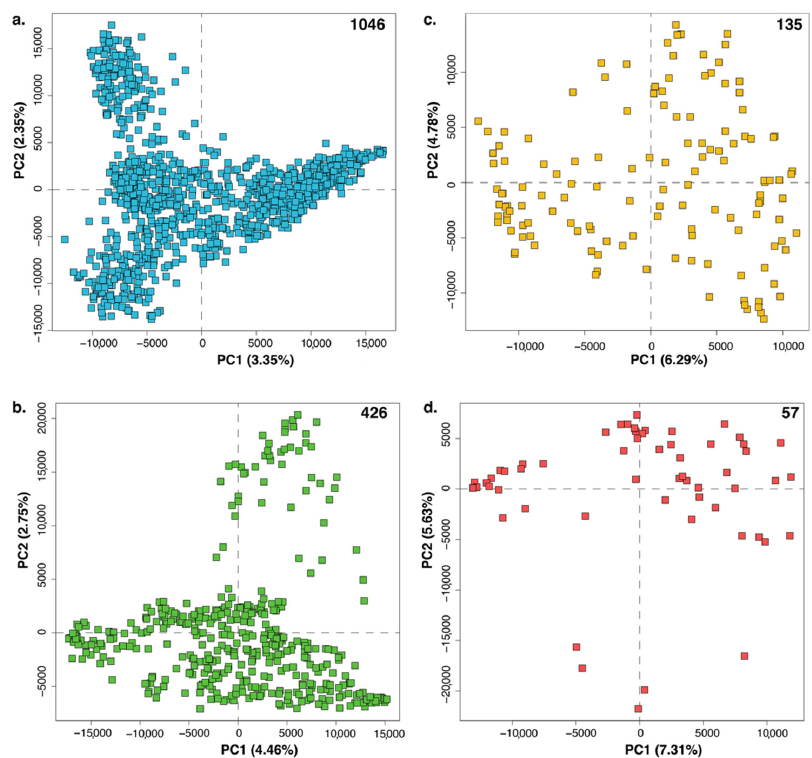
Figure 1. Subplots ( a – d ) show the PCA scores plot for four datasets. The number of samples in each dataset is shown in the top right corner of each plot. The total variance explained by a principal component (PC) is shown in parentheses next to the axis labels on each subplot. As the number of samples in a PCA decreases, the variance explained by each PC increases due to a combination of fewer samples and lesser overall variance in the dataset.